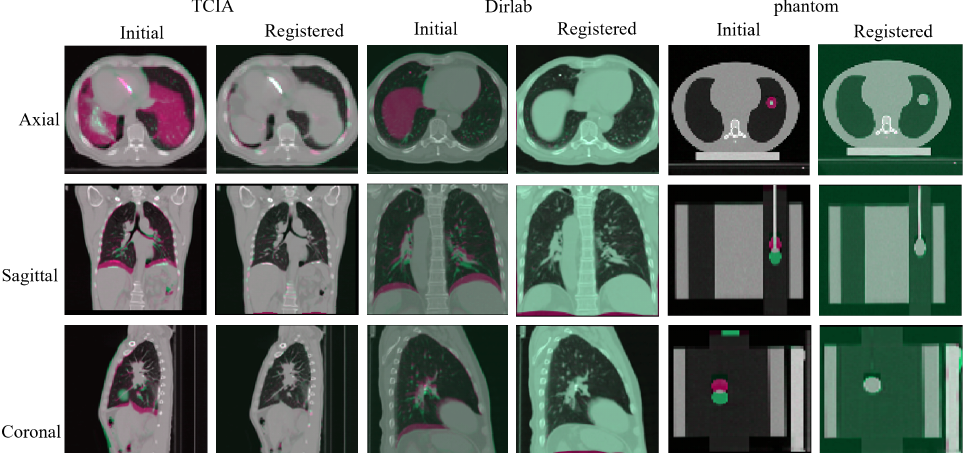
Figure 6. The traditional registration method results from the end of exhalation to the end of inhalation. The first two columns are the registration results on the patient, the middle two are the registration results on the normal human lung, and the last two are the registration results on the phantom. The odd columns are the unregistered images, and the even columns are the results of the registered